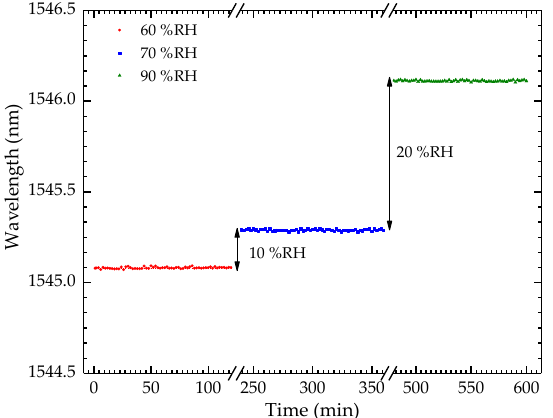
Figure 9. Step technique to estimate the resolution of the humidity sensor.